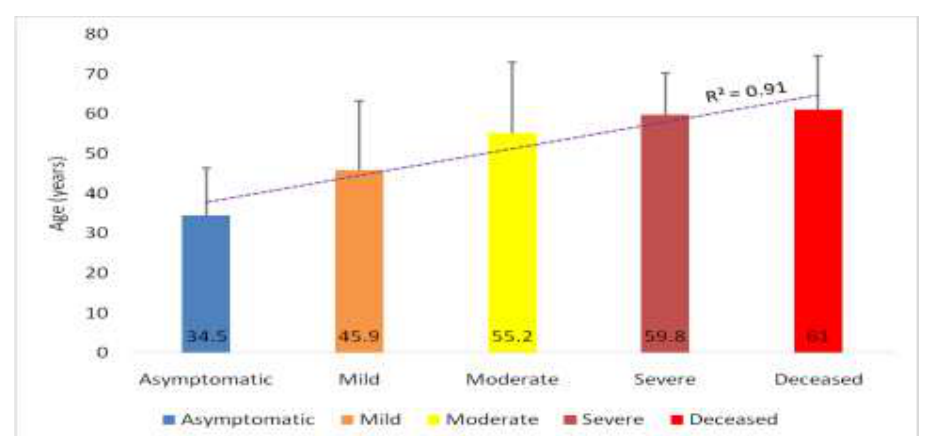
Figure 3: The difference in age (years) in 100 individuals with COVID-19 of various severity